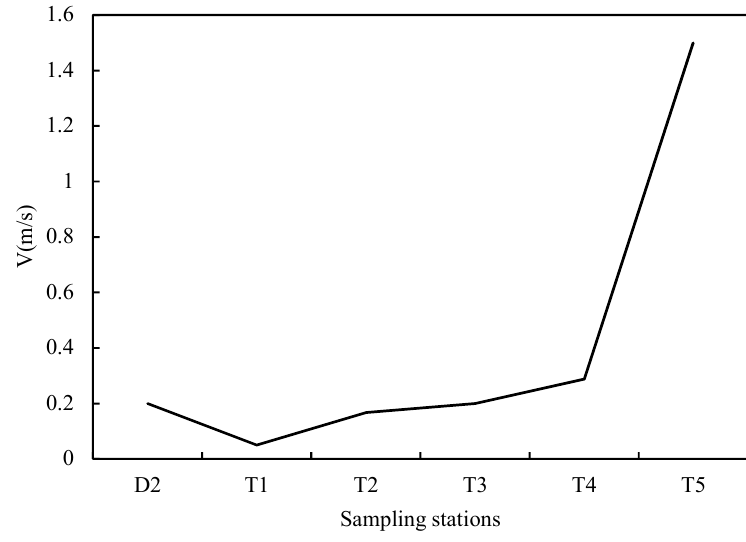
Figure 2. The velocities in the same seven sampling stations in September